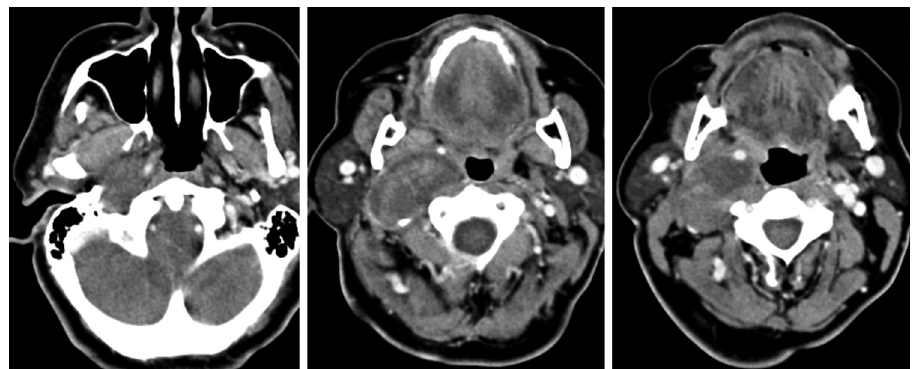
Valgus nerve schwannoma: axial computed tomography shows a heterogeneous mass with well-defined limits, displacing the internal carotid artery and internal jugular vein.